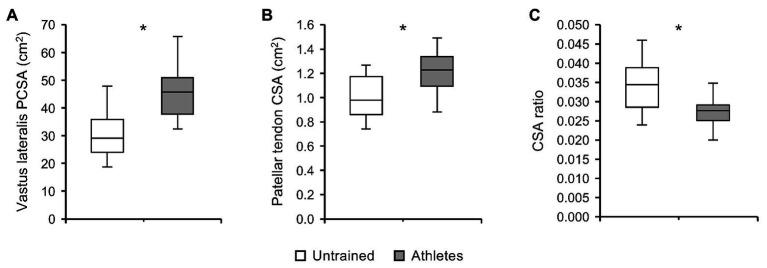
(A) Vastus lateralis physiological cross-sectional area (PCSA), (B) patellar tendon CSA, and (C) ratio of average tendon CSA to VL PCSA of adolescent athletes (gray; n = 14) and untrained controls (white; n = 10). Note that body mass was used as covariate in the statistical analysis of VL PCSA and patellar tendon CSA. *Significant difference (p < 0.05).